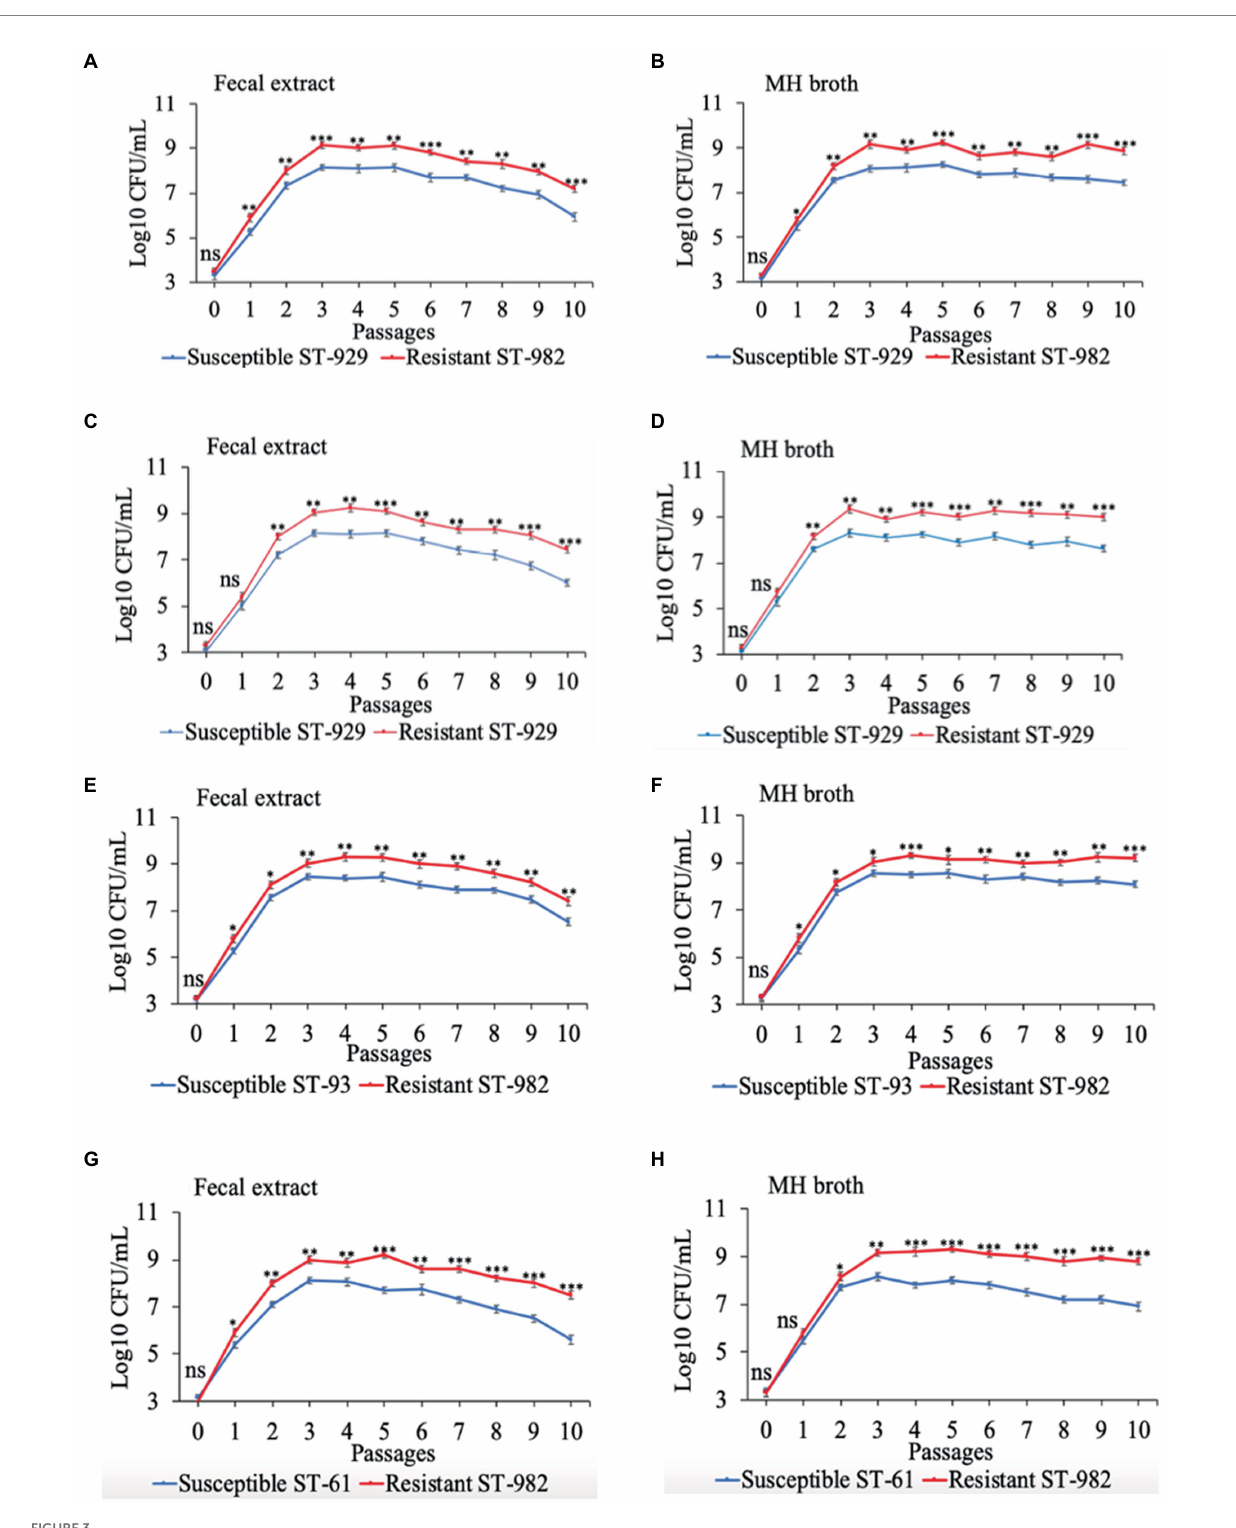
FIGURE 3 Growth kinetics of FQ-resistant Campylobacter jejuni (shown as red lines; resistant ST-982 and resistant ST-929) and FQ-susceptible C. jejuni (shown as blue lines; susceptible ST-929, susceptible ST-93, and susceptible ST-61) strains of various genetic background as determined by pairwise competition experiments in mixed culture in bovine fecal extract (A,C,E,G) and MH broth (B,D,F,H) . The initial bacterial cell density was 10 3 CFU/mL for each strain. The CFU of each strain at the baseline of each passage was calculated (24 h interval). Significant differences between resistant and susceptible strains are indicated by asterisks: p -values less or equal to 0.001 are summarized with three asterisks, p -values less or equal to 0.01 are summarized with two asterisks, and p -values less or equal to 0.05 are summarized with one asterisk. The experiment was repeated twice, and the results of one representative experiment are